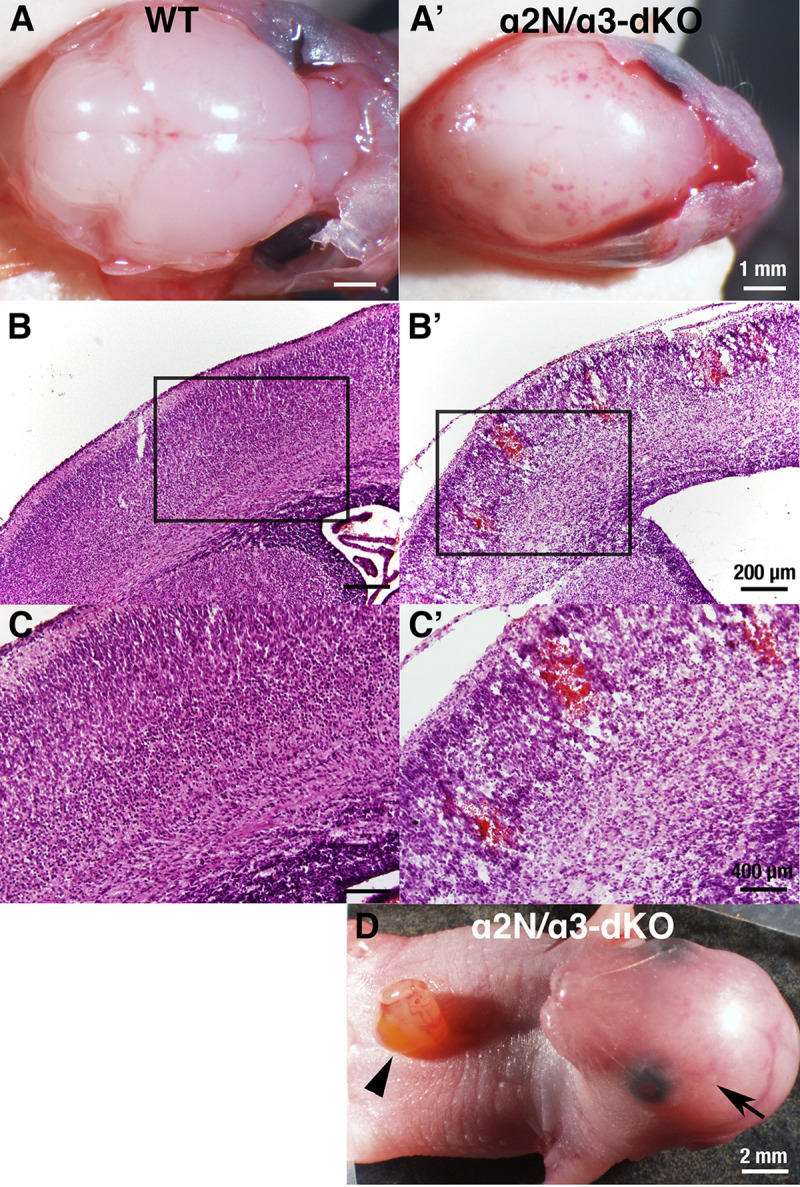
Phenotype of wild-type (WT) and Atp1a2-N/Atp1a3 double homozygous knockout (α2N/α3-dKO) mice.A, A’. Gross examination of the surface of the brains of WT and α2N/α3-dKO newborn mice after removal of the cranial bones. The α2N/α3-dKO showed petechiae and ecchymoses over cerebral convexity. Scale bars, 1 mm. B, B’. Microscopic examination of the cortex. Intraparenchymal haemorrhage in the cortex of α2N/α3-dKO are shown. Scale bars, 200 μm. C, C’. Magnification of the boxed regions in B and B’, respectively. Scale bars, 400 μm. D. Abdominal wall rupture observed in α2N/α3-dKO mice (arrowhead). Brain haemorrhage was observed through the skin and cranial bones (arrow). Scale bars, 2 mm.